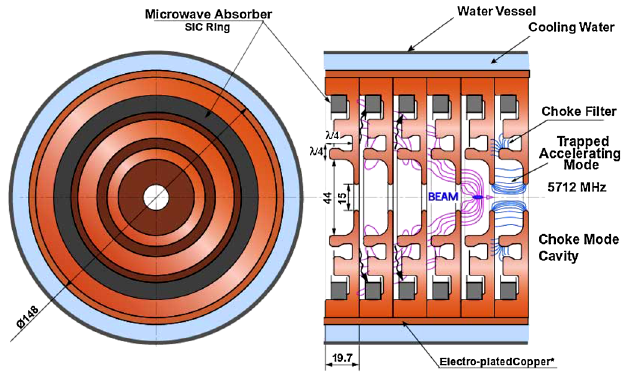
FIG. 5. (Color) C-band choke mode damped cavity